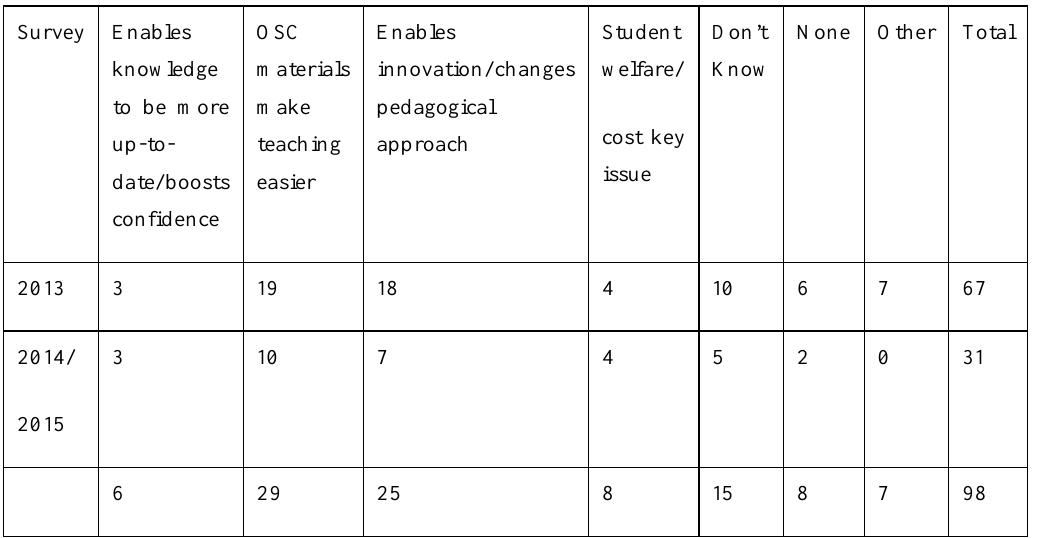
impacted on your own teaching